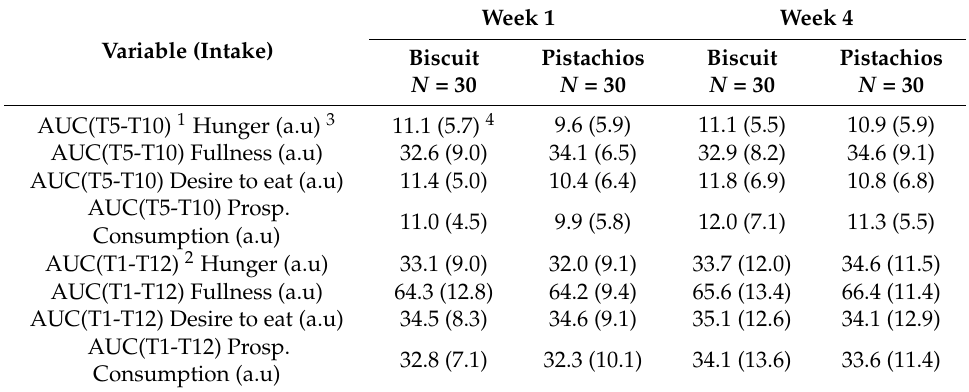
Table 4. Mean subjective appetite responses from visual analogue scales after intake of biscuits or pistachio as goûter (T5–T10) and throughout the day (T1–T12) by women during the first and the last week of the